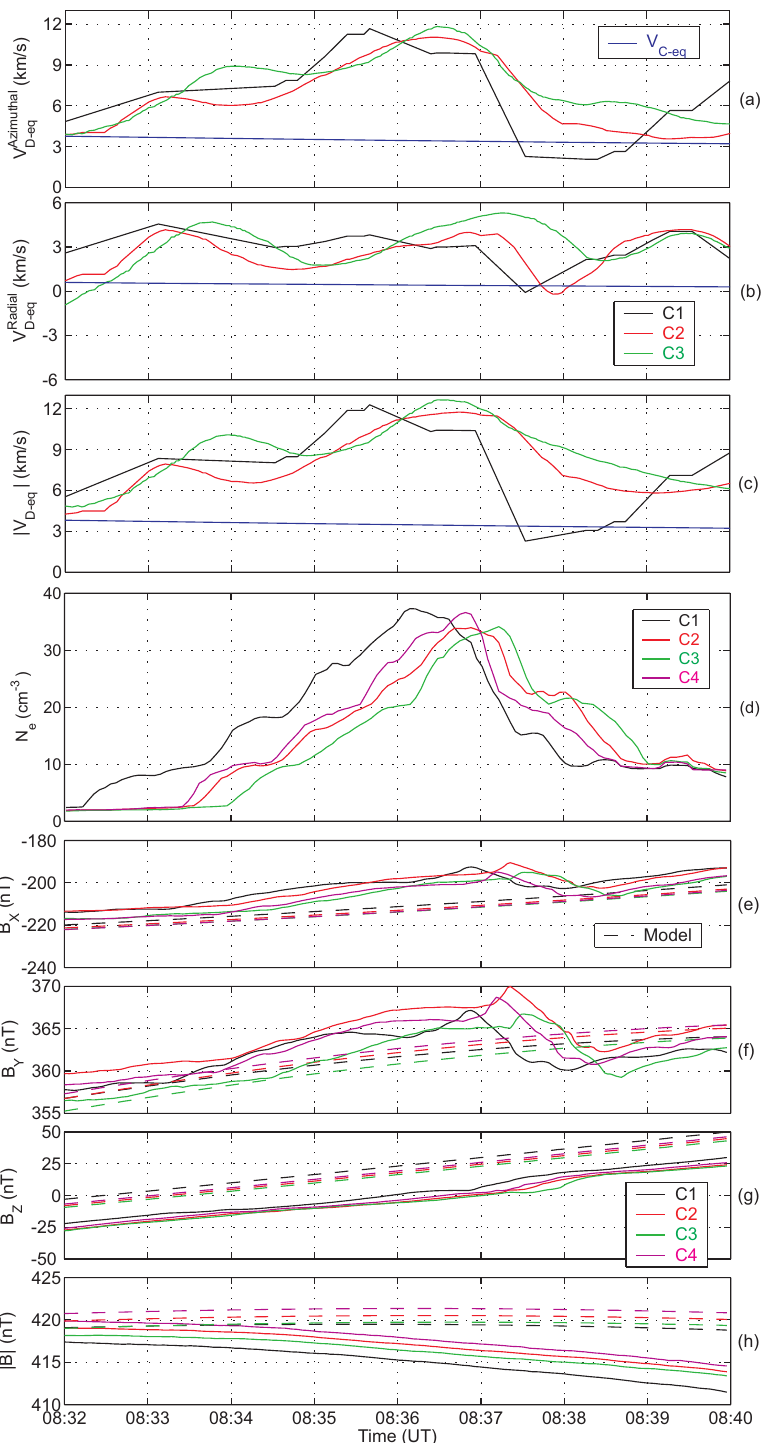
Fig. 6. Different quantities plotted as a function of time during the inbound plume crossing of 7 May 2002: (a)–(c) electron drift velocity measured by EDI and projected onto the magnetic equatorial plane (similar as Fig. 5); (d) electron density determined by WHISPER; (e)–(h) magnetic field components and magnitude in the GSE coordinate system measured by FGM (in solid lines) and determined from IGRF2000 and Tsyganenko-96 models (in dotted